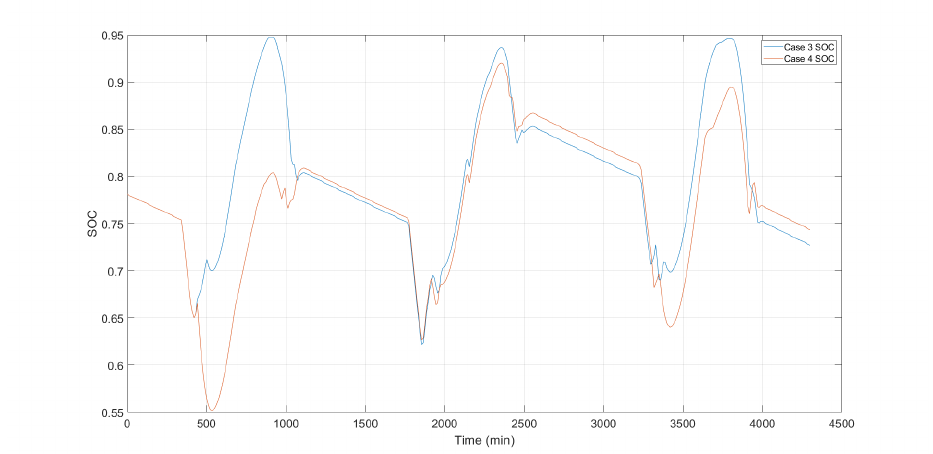
Figure 14. Batteries’ SOC evolution. SOC’s evolution without aerator 1 reschedule (blue), SOC’s evolution with aerator 1 reschedule (orange).